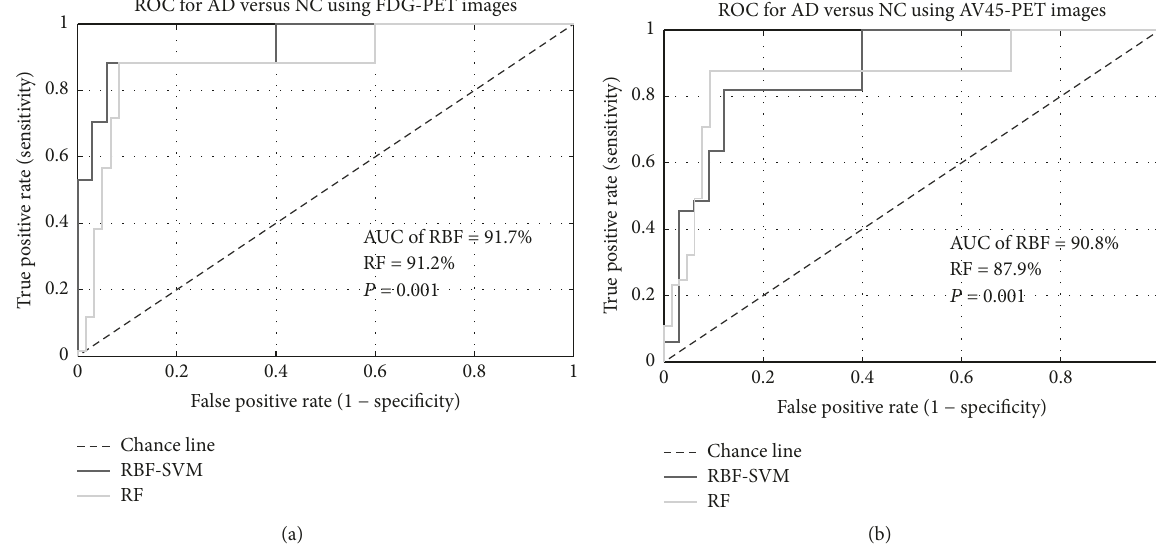
Figure 6: Receiver Operating Characteristic (ROC, sensitivity versus specificity) curves for classification between AD and NC using longitudinal data for (a) FDG-PET images (AD versus NC) and (b) AV45-PET